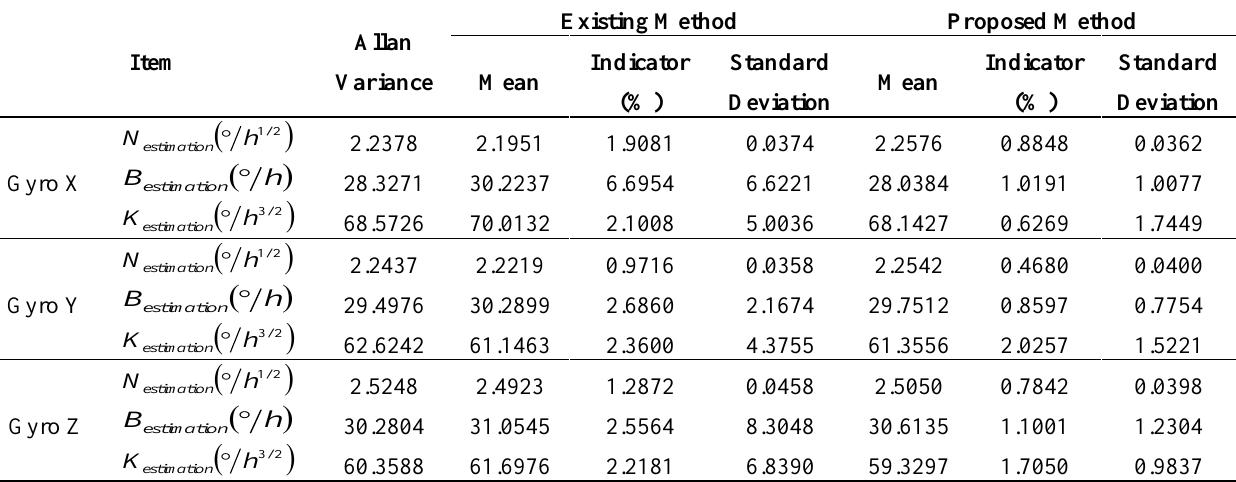
Table 2. Parameter estimation results of different